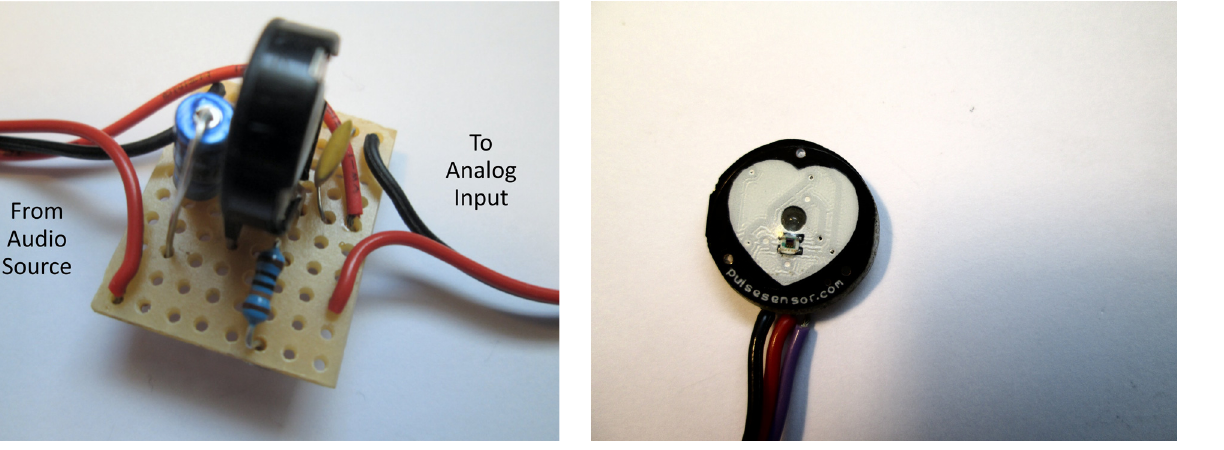
Figure 7: Audio - to - analog adapter.